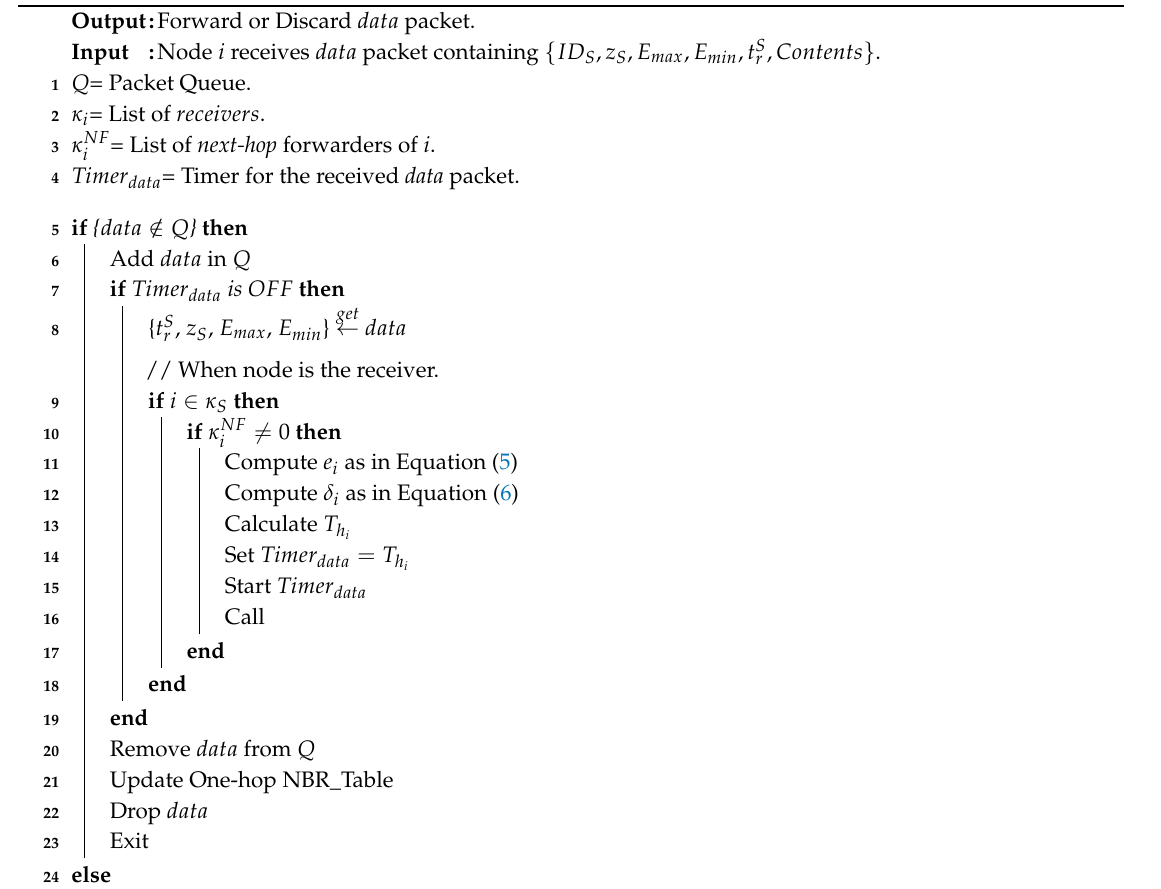
Algorithm 1: Proposed EDOVE